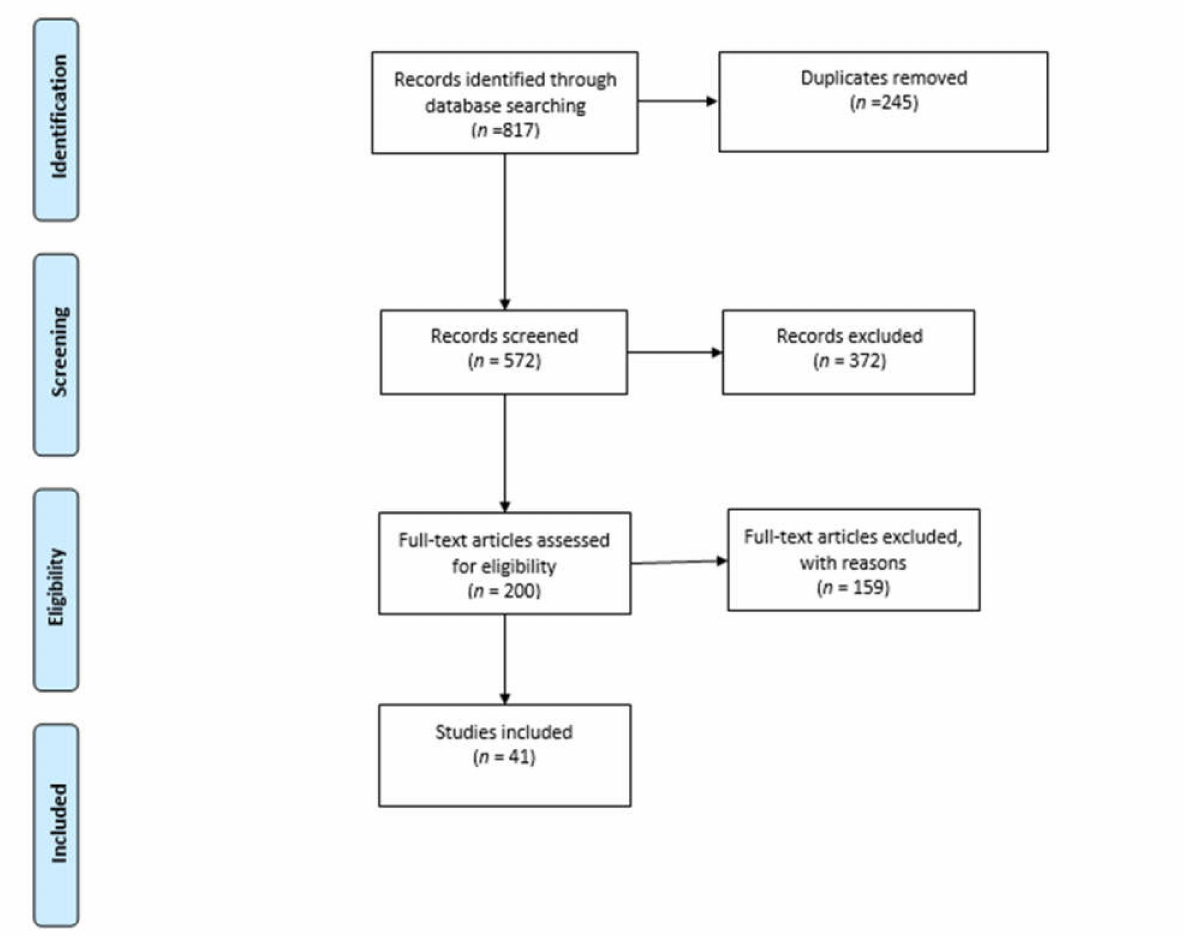
Figure 1. PRISMA diagram of database research publication selection